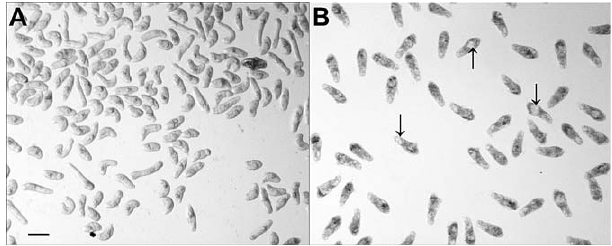
Figure 8. Photomicrographs (100 3 ) of Irrelevant dsRNA-Treated Schistosomula (left image) and TGR dsRNA-Treated Schistosomula (right image) after Three Days of Treatment All organisms in the left image are alive; parasites have different shapes, elongated, contracted, and curved during movement. In the right image, all of the parasites are dead and have roughly the same shape (no movement) and internal vacuoles (arrows). The bar represents 250 l m.